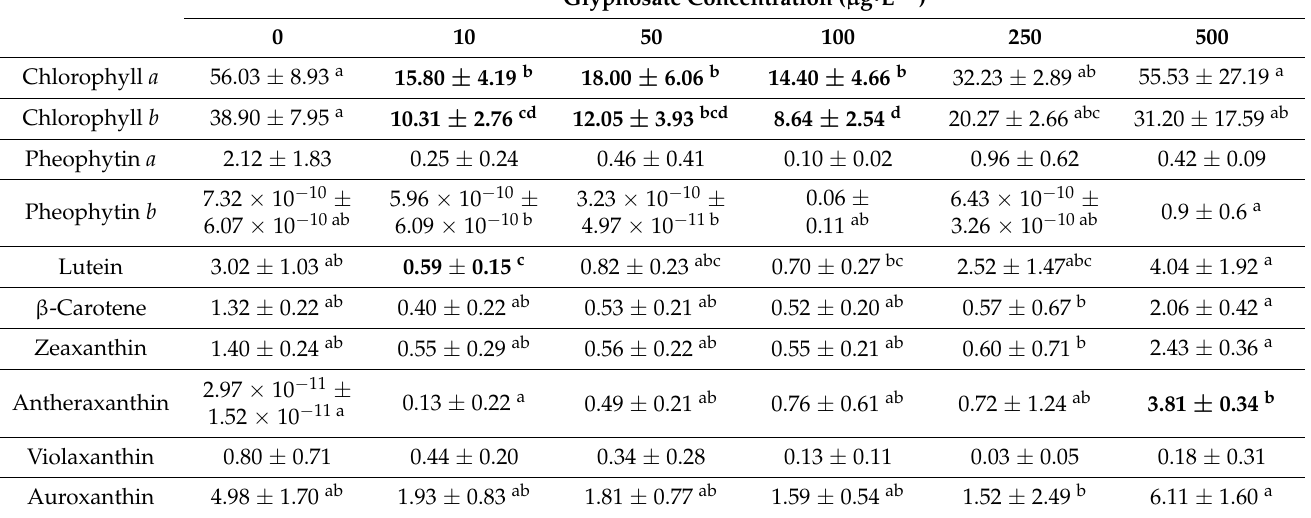
Table 2. Pigment profile content ( µ g · g − 1 FW) in Ulva lactuca following a 48-h exposure to a glyphosate- based herbicide formulation in different concentrations (mean ± s.d., n = 3, different letters indicate significant differences between treatments at p < 0.05; numbers in bold indicate significant deviation from